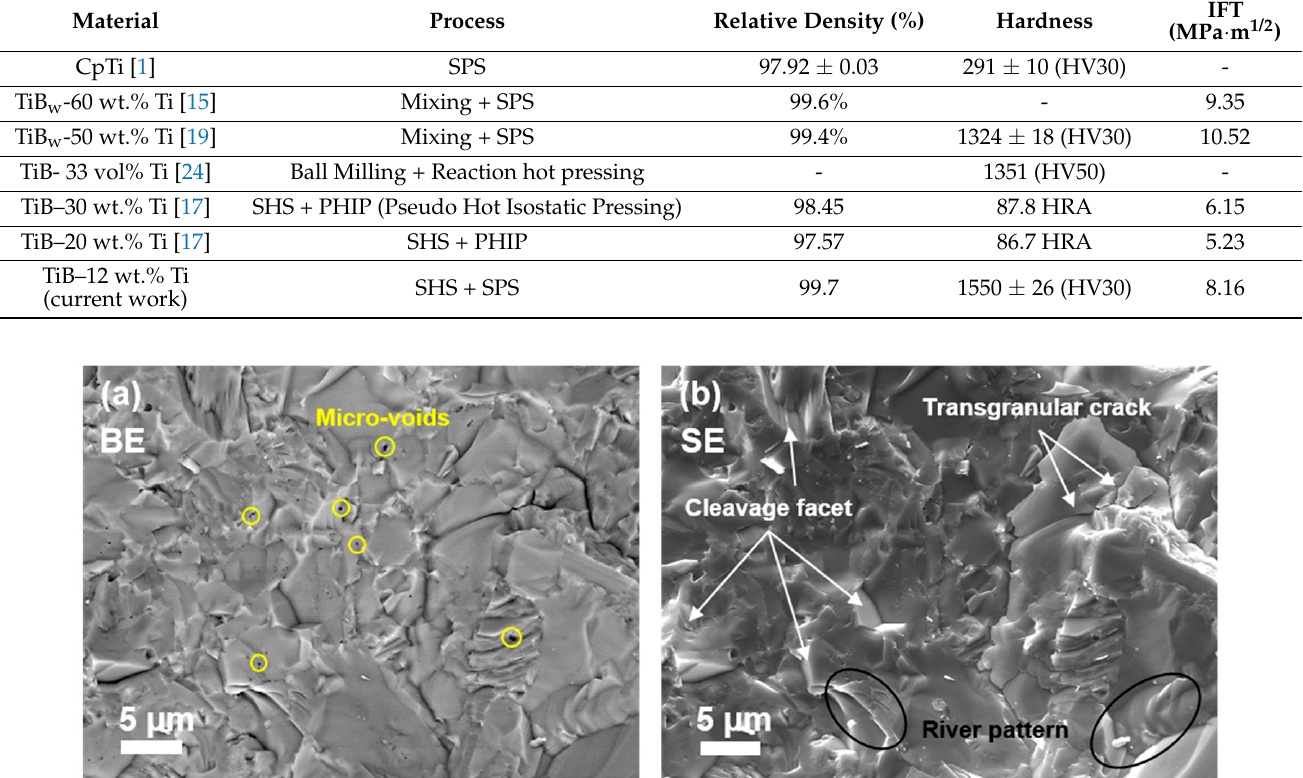
Figure 3. SEM images of fractured cross-sections: ( a ) Backscattered electron (BE); and ( b ) secondary electron (SE). Table 2. Comparison of processing methods, relative density, hardness and indentation fracture toughness of Ti-TiB com- posites.